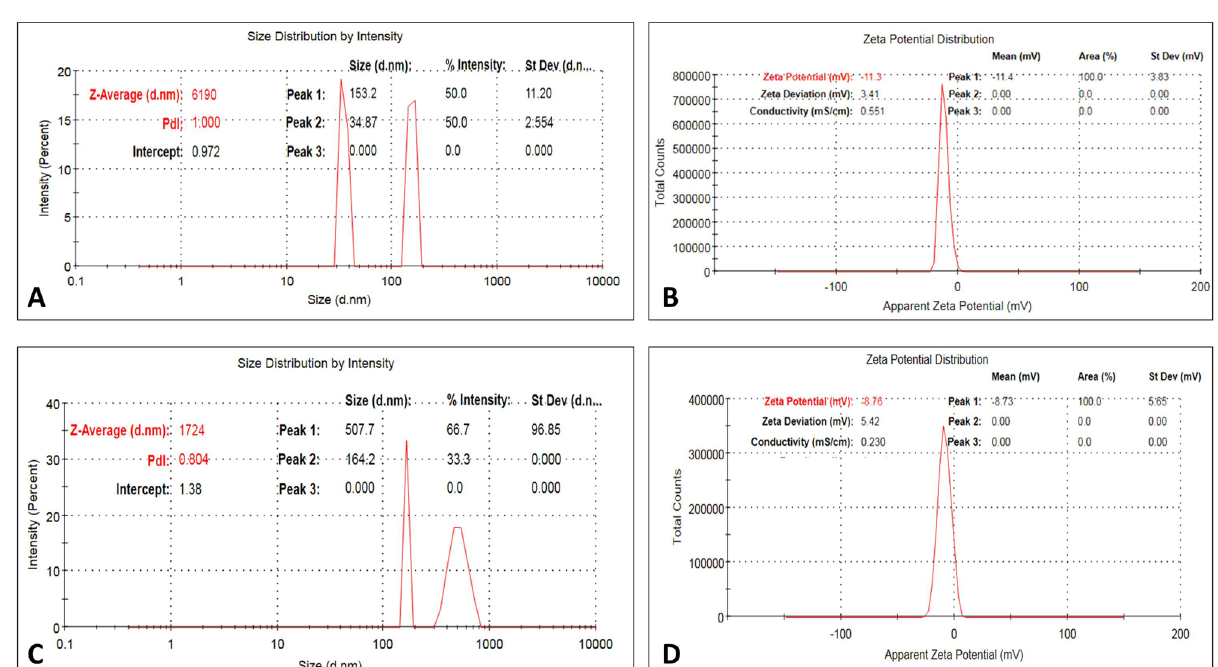
Figure 3. Nile Tilapia fish scale-based collagen nanoparticles prepared by ethanol desolvation showing size distribution by intensity ( A ) and zeta (ζ) potential distribution ( B ). Nile Tilapia fish scale-based collagen nanoparticles prepared by acetone desolvation showing size distribution by intensity ( C ) and ζ potential distribution ( D